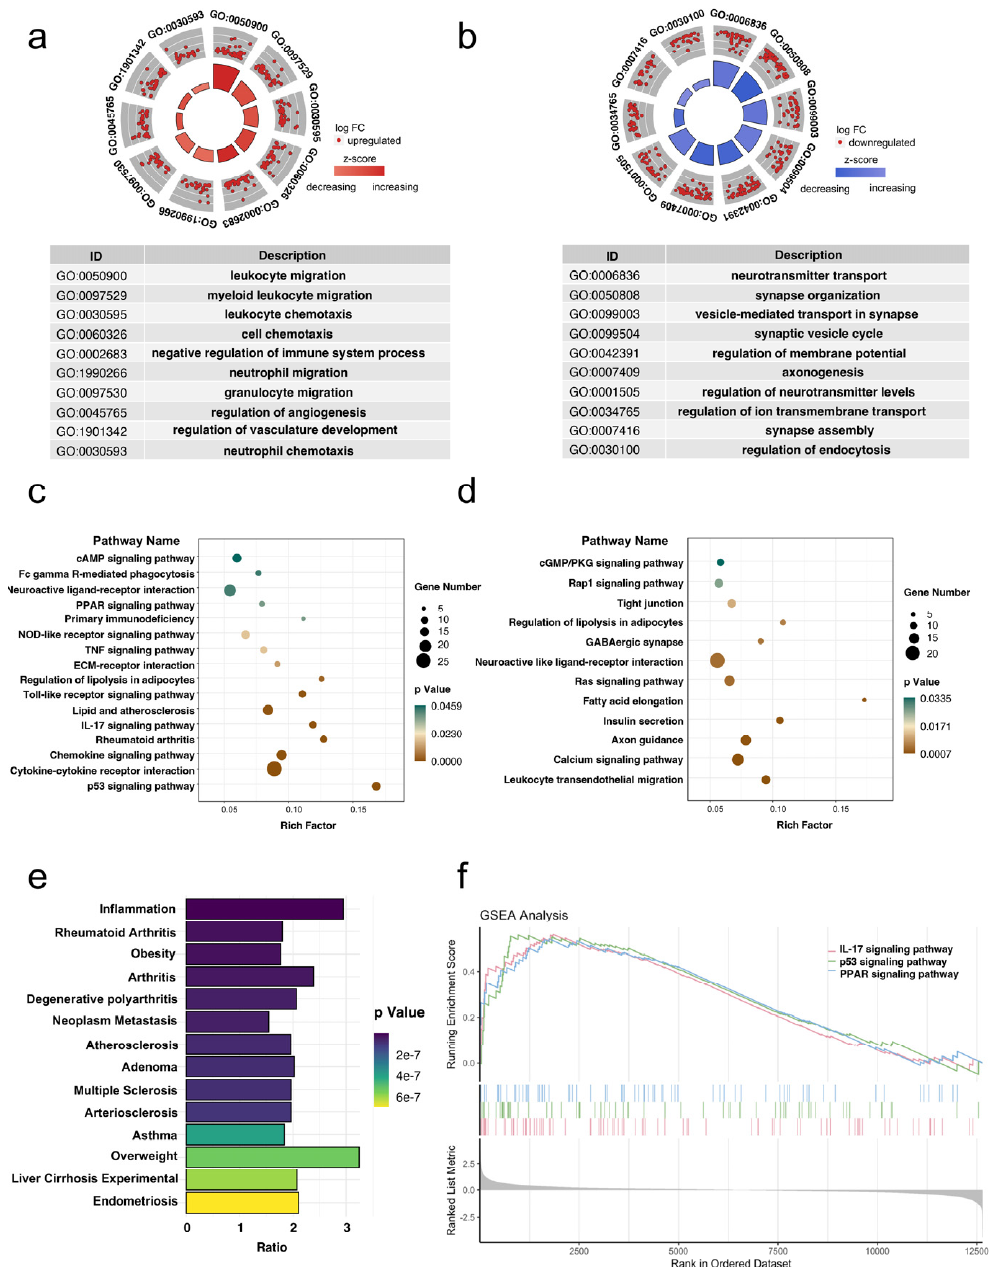
Figure 3. Enrichment analyses of gene ontology (GO), KEGG pathway, disease ontology (DO), and gene set enrichment analysis (GSEA). ( a ) The upregulated biological processes and ( b ) the downregulated biological processes in the DPN group. The top 10 are listed. The nodes in the concentric circle represent the DEGs clustered in the GO annotations. The red and blue colors represent upregulated DEGs and downregulated DEGs, respectively. ( c , d ) KEGG pathway enrichment analysis of upregulated and downregulated DEGs of the DPN group. ( e ) The enrichment analysis of disease ontology. ( f ) Gene set enrichment analysis (GSEA). The IL-17 signaling pathway, P53 signaling pathway and PPAR signaling pathway were significantly enriched.